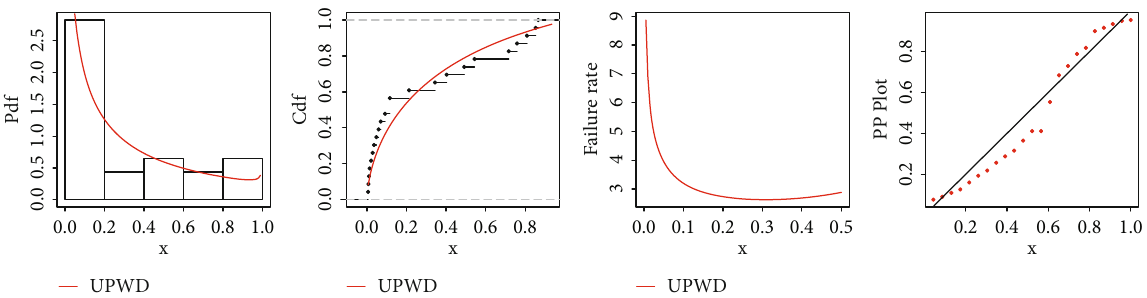
Figure 13: Graphical illustration of estimated pdf, cdf, failure rate, and P-P for data